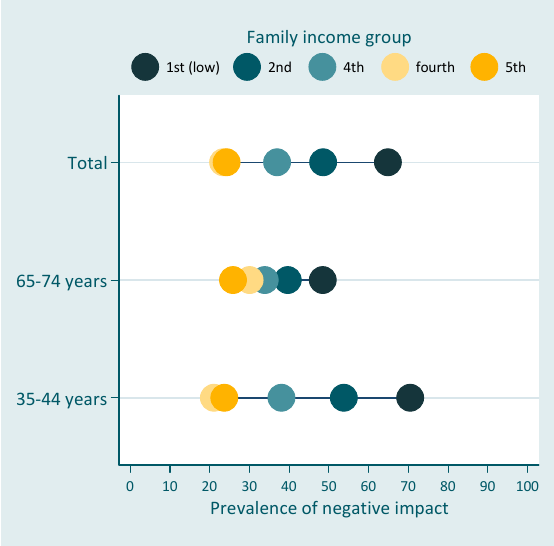
Figure 2. Prevalence of the negative impact of oral health on quality of life across family income for the total population and among age-groups (equiplot). Family income groups (in reais) = 1st = ≤ 500; 2nd = 501–1500; 3rd = 1501–2500; 4th = 2501–4500; 5th = 4501+.